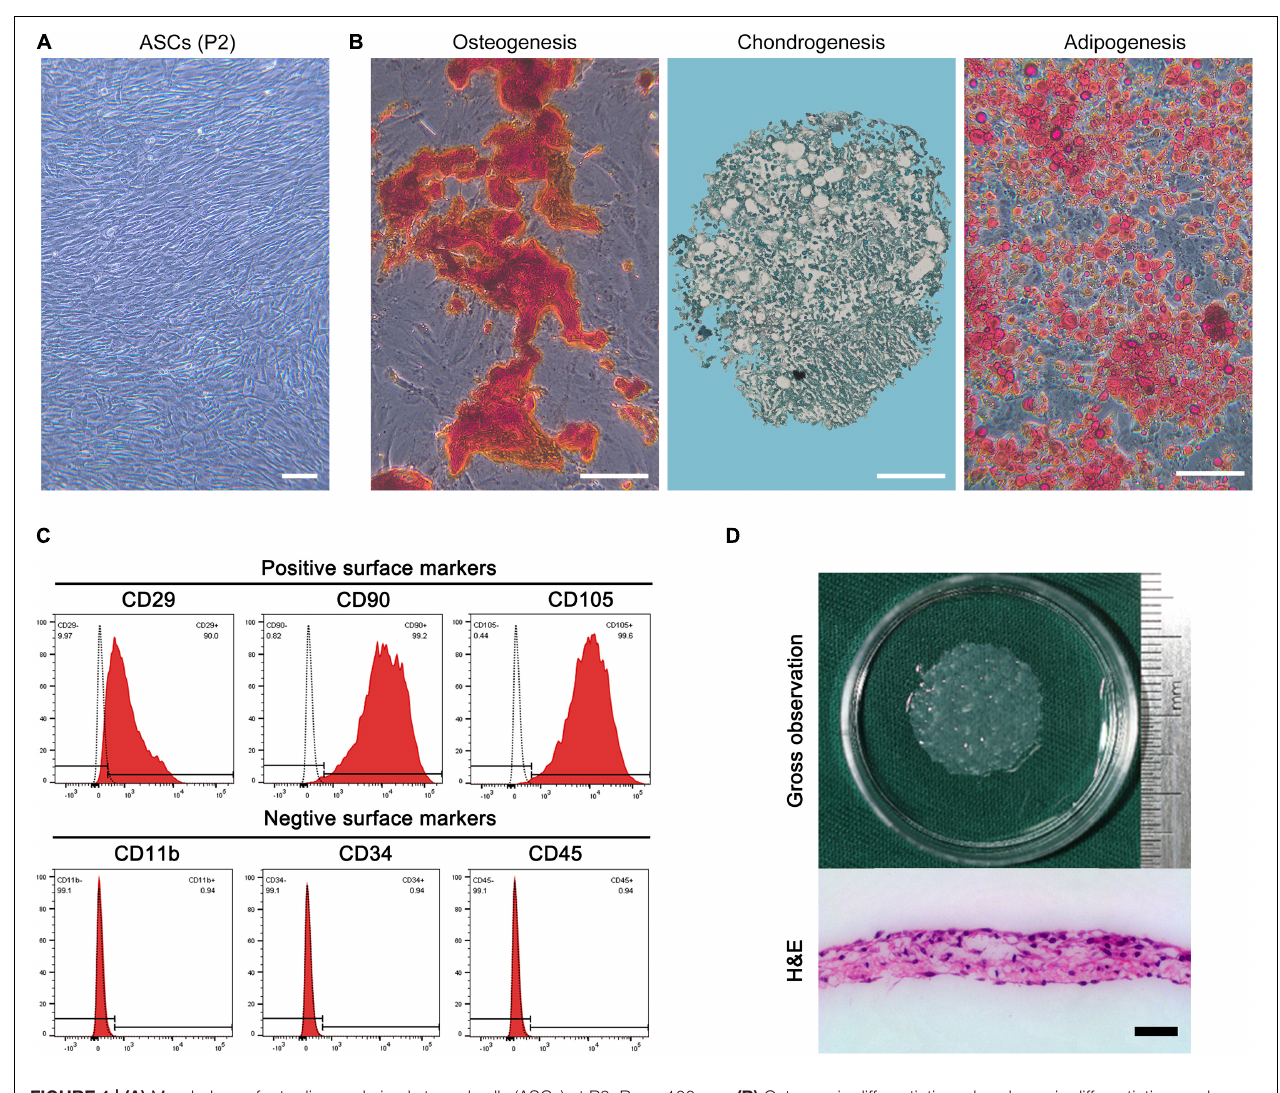
FIGURE 1 | (A) Morphology of rat adipose-derived stromal cells (ASCs) at P2. Bar = 100 µ m. (B) Osteogenic differentiation, chondrogenic differentiation, and adipogenic differentiation of ASCs revealed by alizarin red, alcian blue, and oil red O staining. Bar = 100 µ m. (C) Flow cytometry analysis of the expression of cell surface markers related to stem cell phenotype in ASCs, which were positive for CD29, CD90, and CD105 and negative for CD11b, CD34, and CD45. (D) Macroscopic morphology and H&E-stained image of the ASC sheet. Bar = 50 µ